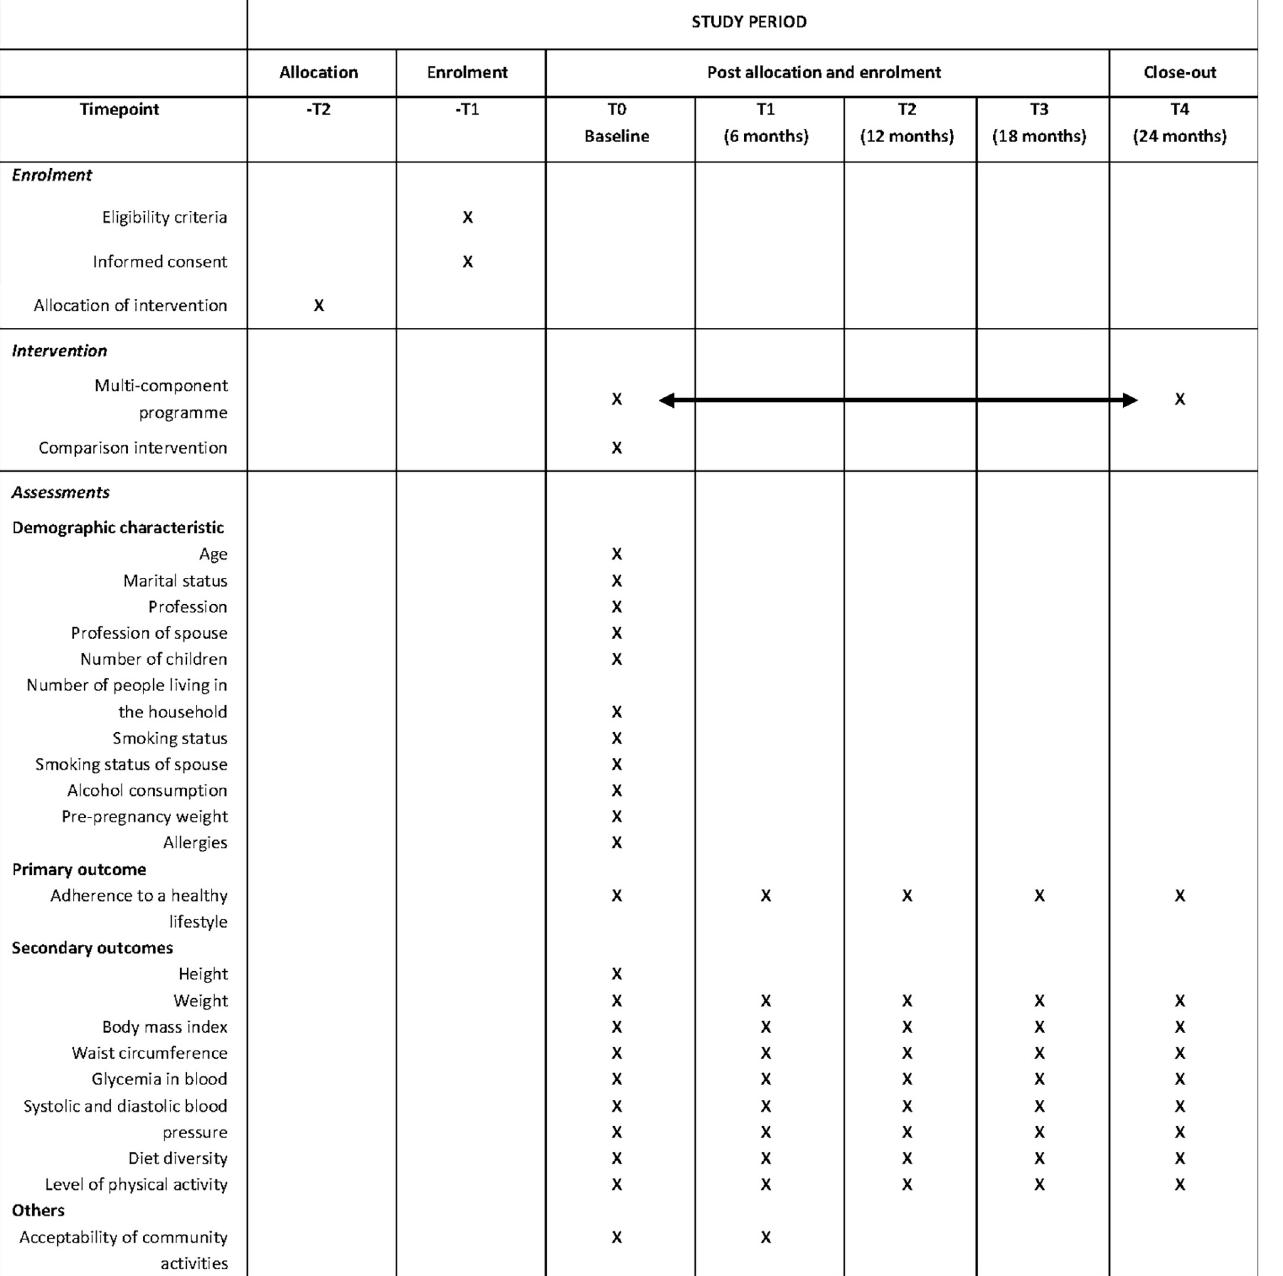
Fig 1. SPIRIT flow diagram of enrolment, intervention and